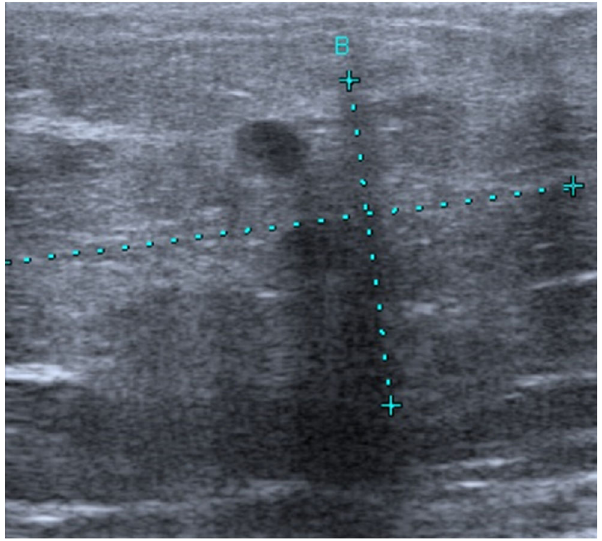
Fig. 6 Haematoma. Patient followed for right breast cancer treated in 1998, referred for opinion concerning a mammographic opacity of the